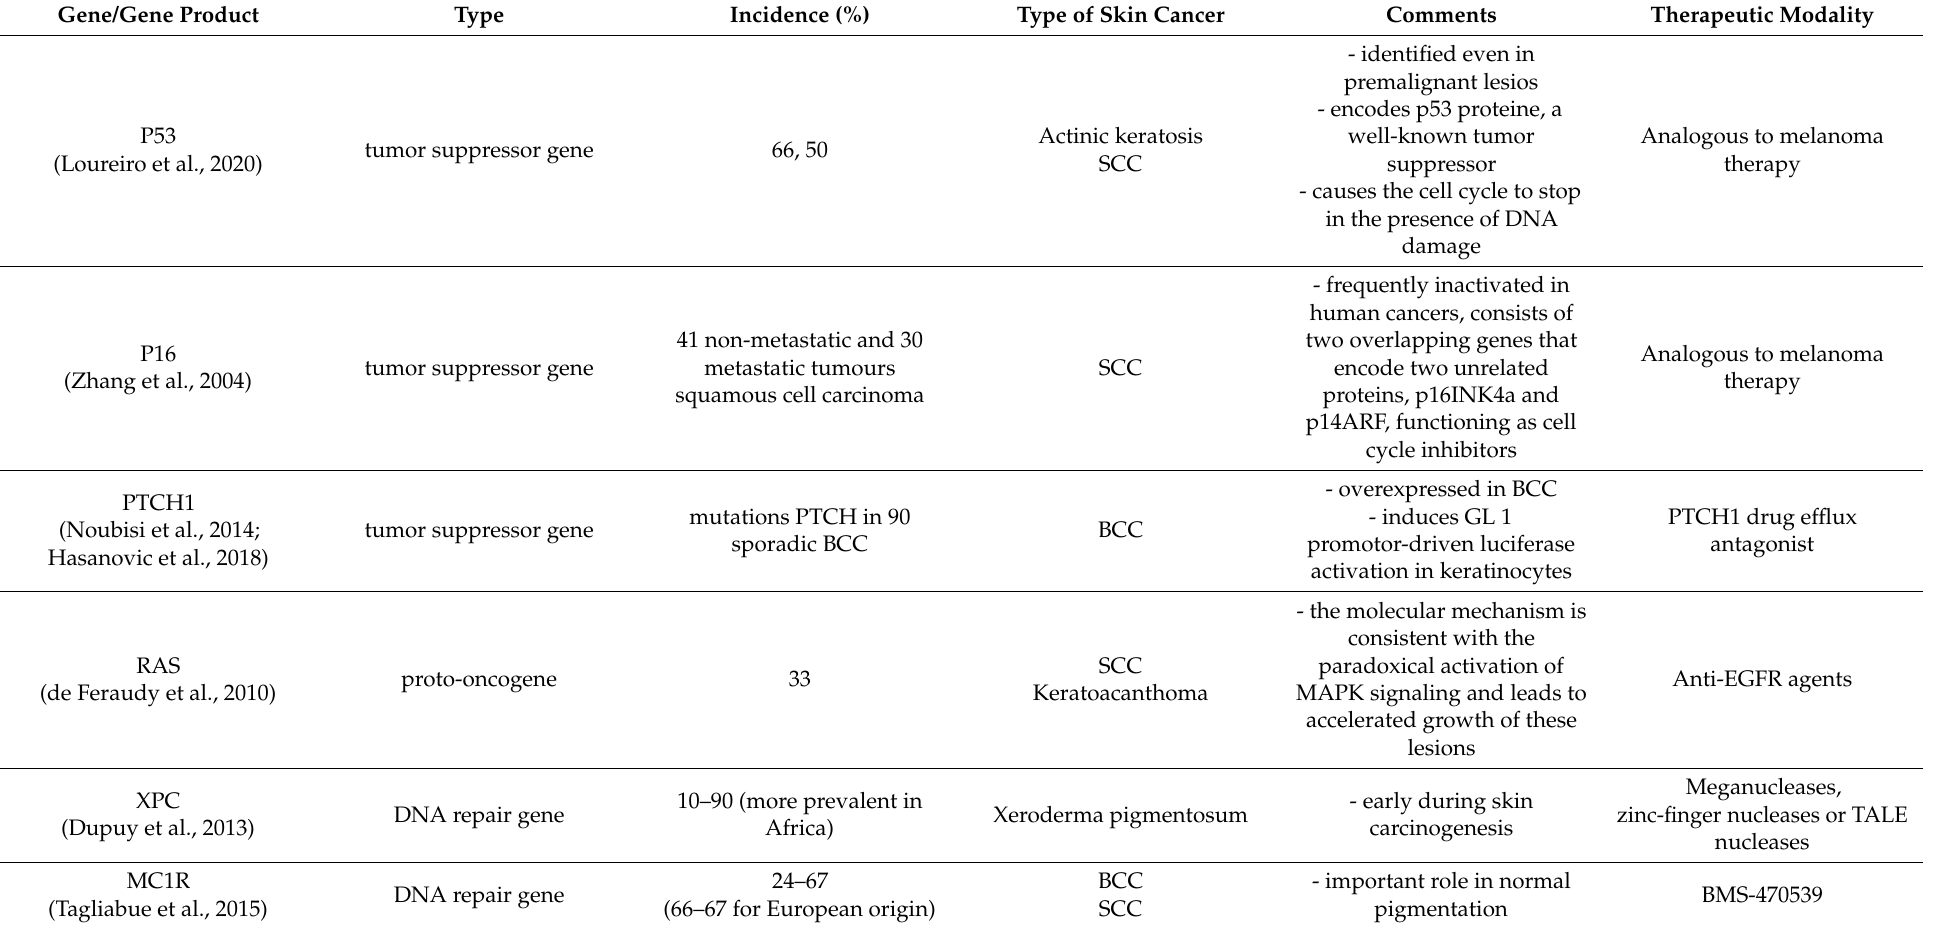
Table 3. Gene mutations in non-melanoma skin